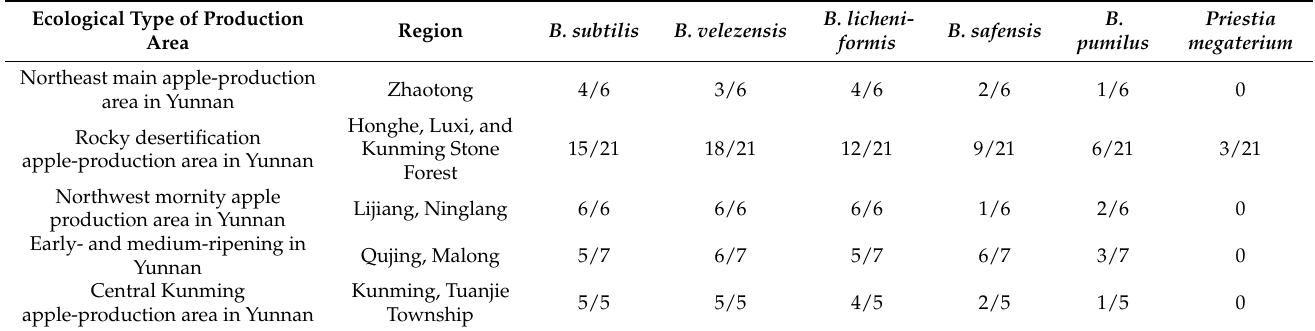
Table 1. Distribution frequency of CEB types in apple-producing areas of